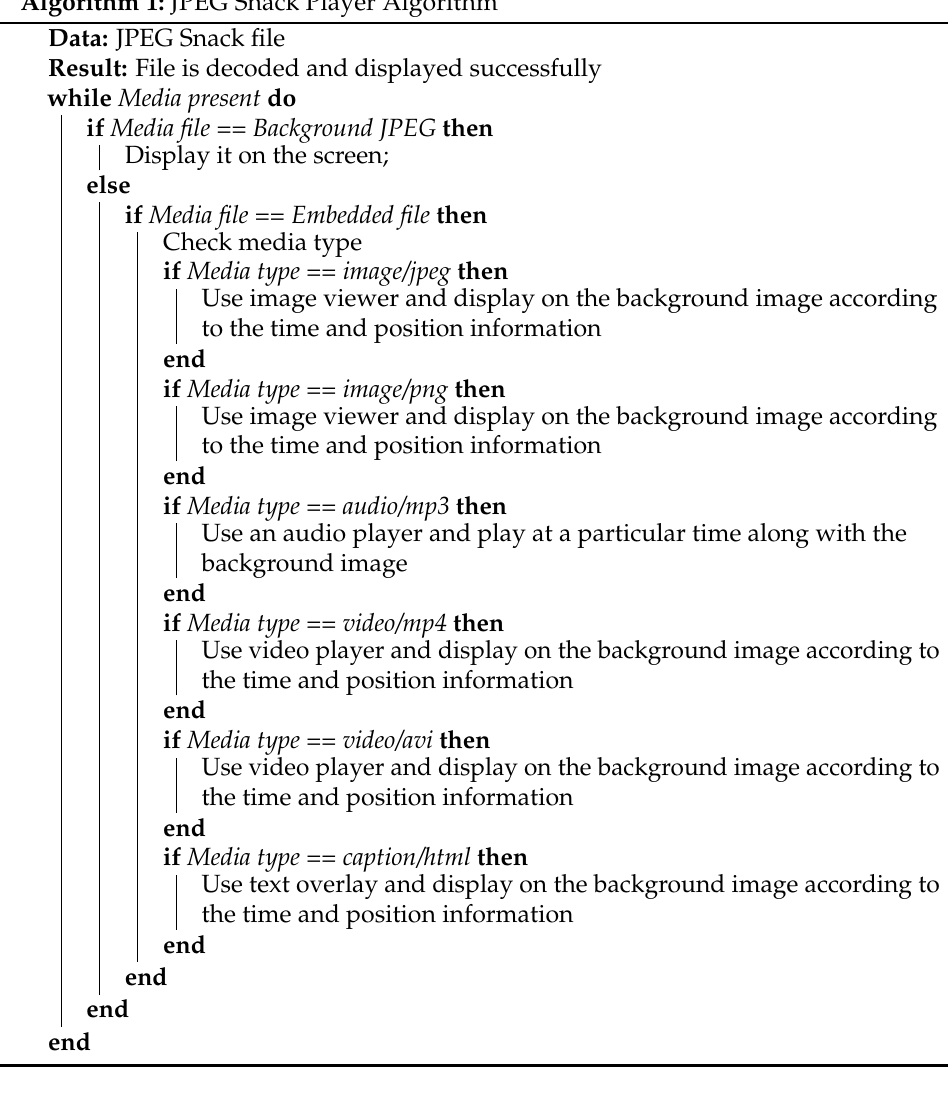
Algorithm 1: JPEG Snack Player Algorithm Data: JPEG Snack